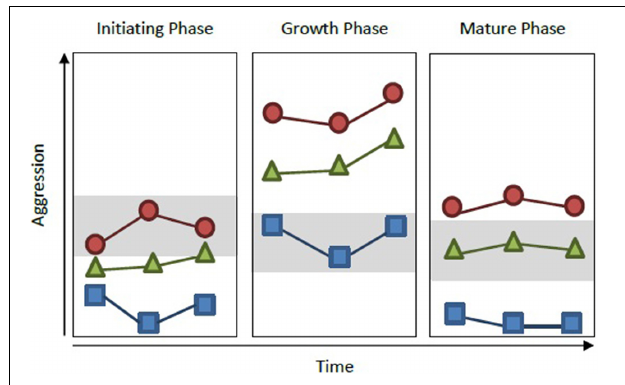
FIGURE 1 | Measuring group personality throughout development. Collective personality is typically measured on groups during one phase of development (typically either the growth or mature phase). However, personality can shift through developmental phases. In Pogonomyrmex ants, for instance, colony aggression increases during growth phase, but decreases after reaching maturity (Gordon, 1991, 1995). In the hypothetical example shown here, if measurements were taken on three different colonies (red circle, blue square, and green triangle) within and across each of these developmental phases, colonies would exhibit consistent personality differences. However, if colonies were measured only once, but at different phases of development (e.g., red circle during initiating phase, blue square during growth phase, and green triangle during mature phase), colony aggression levels would overlap significantly (gray boxes) and one would come to the incorrect conclusion that colonies do not vary in personality